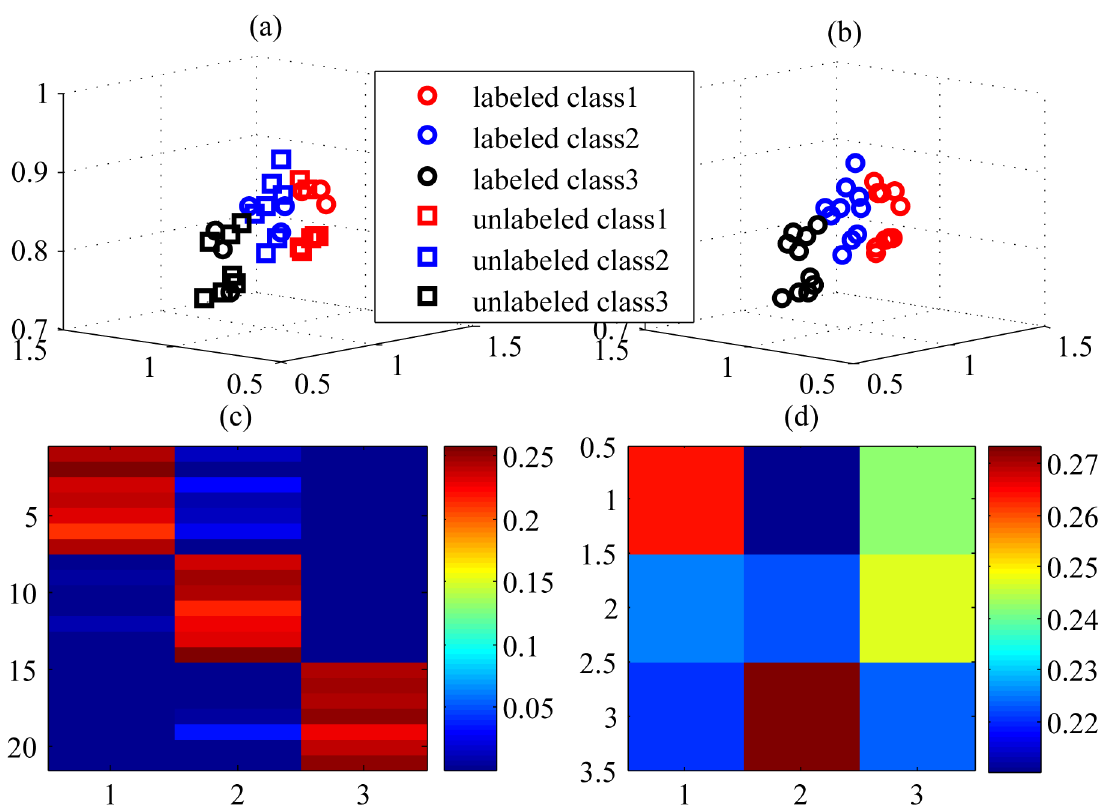
Fig 1. The toy example illustrating (a) the synthetic 3D original data including the labeled and unlabeled samples and the ground-truth labels, (b) the labeled results of unlabeled samples, (c) the learned coefficients of the unlabeled samples, and (d) the learned basis by Semi-PNMF. In Fig (a), both the square and circle markers signify the unlabeled and labeled samples, respectively, and three different colors stand for three different categories. Fig (b) shows that the unlabeled samples are marked as the ground-truth markers and colors. Figs (c) and (d) shows the coefficients and basis learned by Semi- PNMF, respectively. The index of maximum value of the coefficient for an unlabeled sample appears in red and indicates its class.